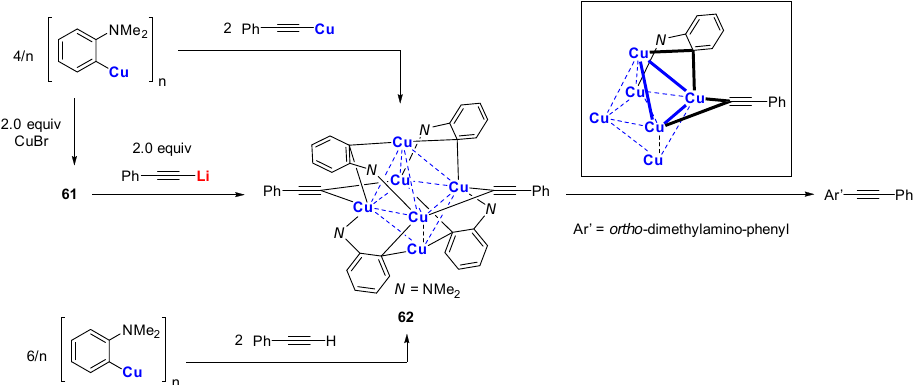
nn Scheme 17. Selective coupling from the thermolysis of hexanuclear organocopper cluster [109–112]. Figure 9. Molecule structure of 62 ; drawn based on